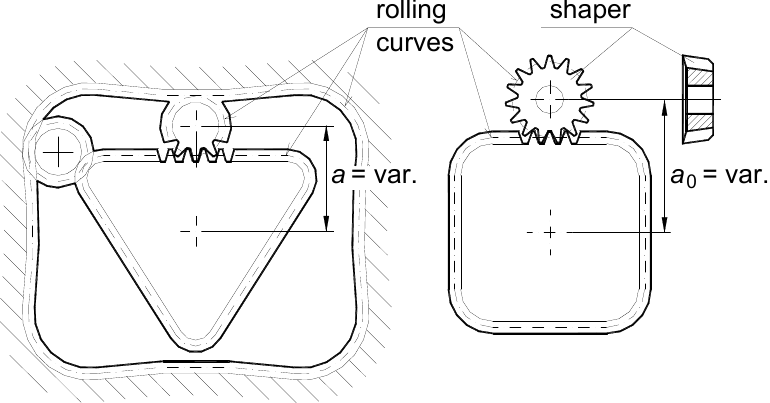
Figure 9. Examples of technological transmission for a shaper and a non-circular gear [14,15].